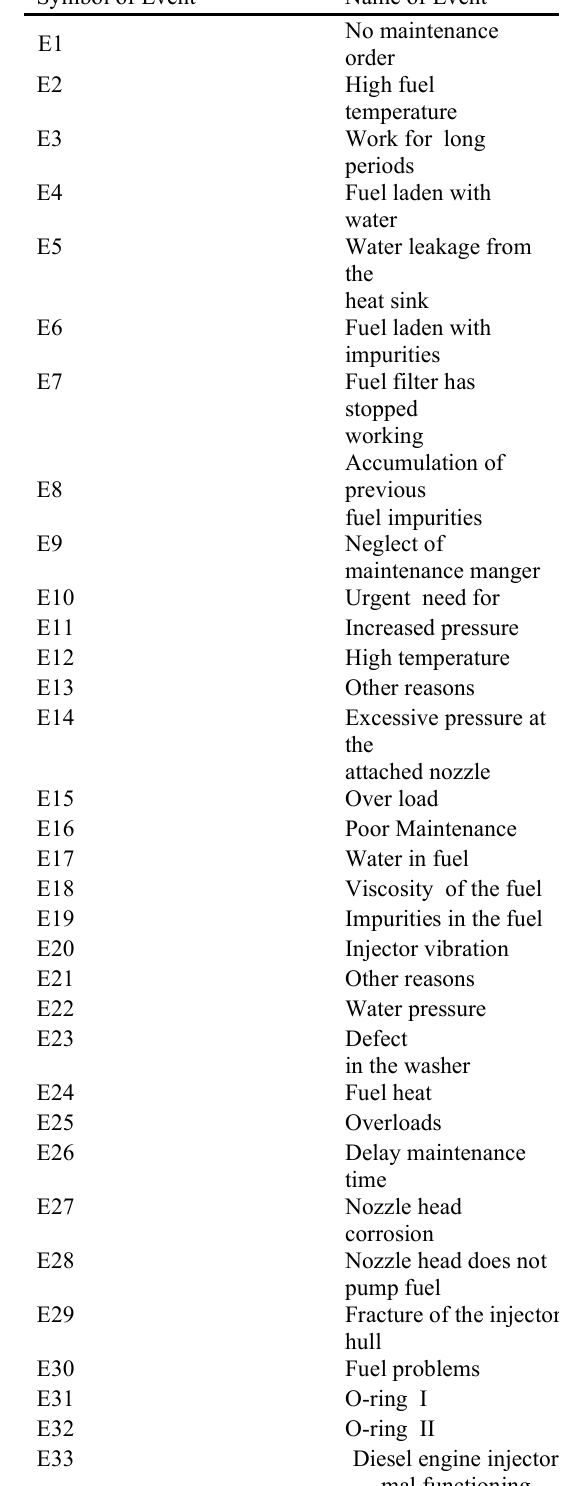
The nomenclature of the main problems of the occurrence of malfunctions and their